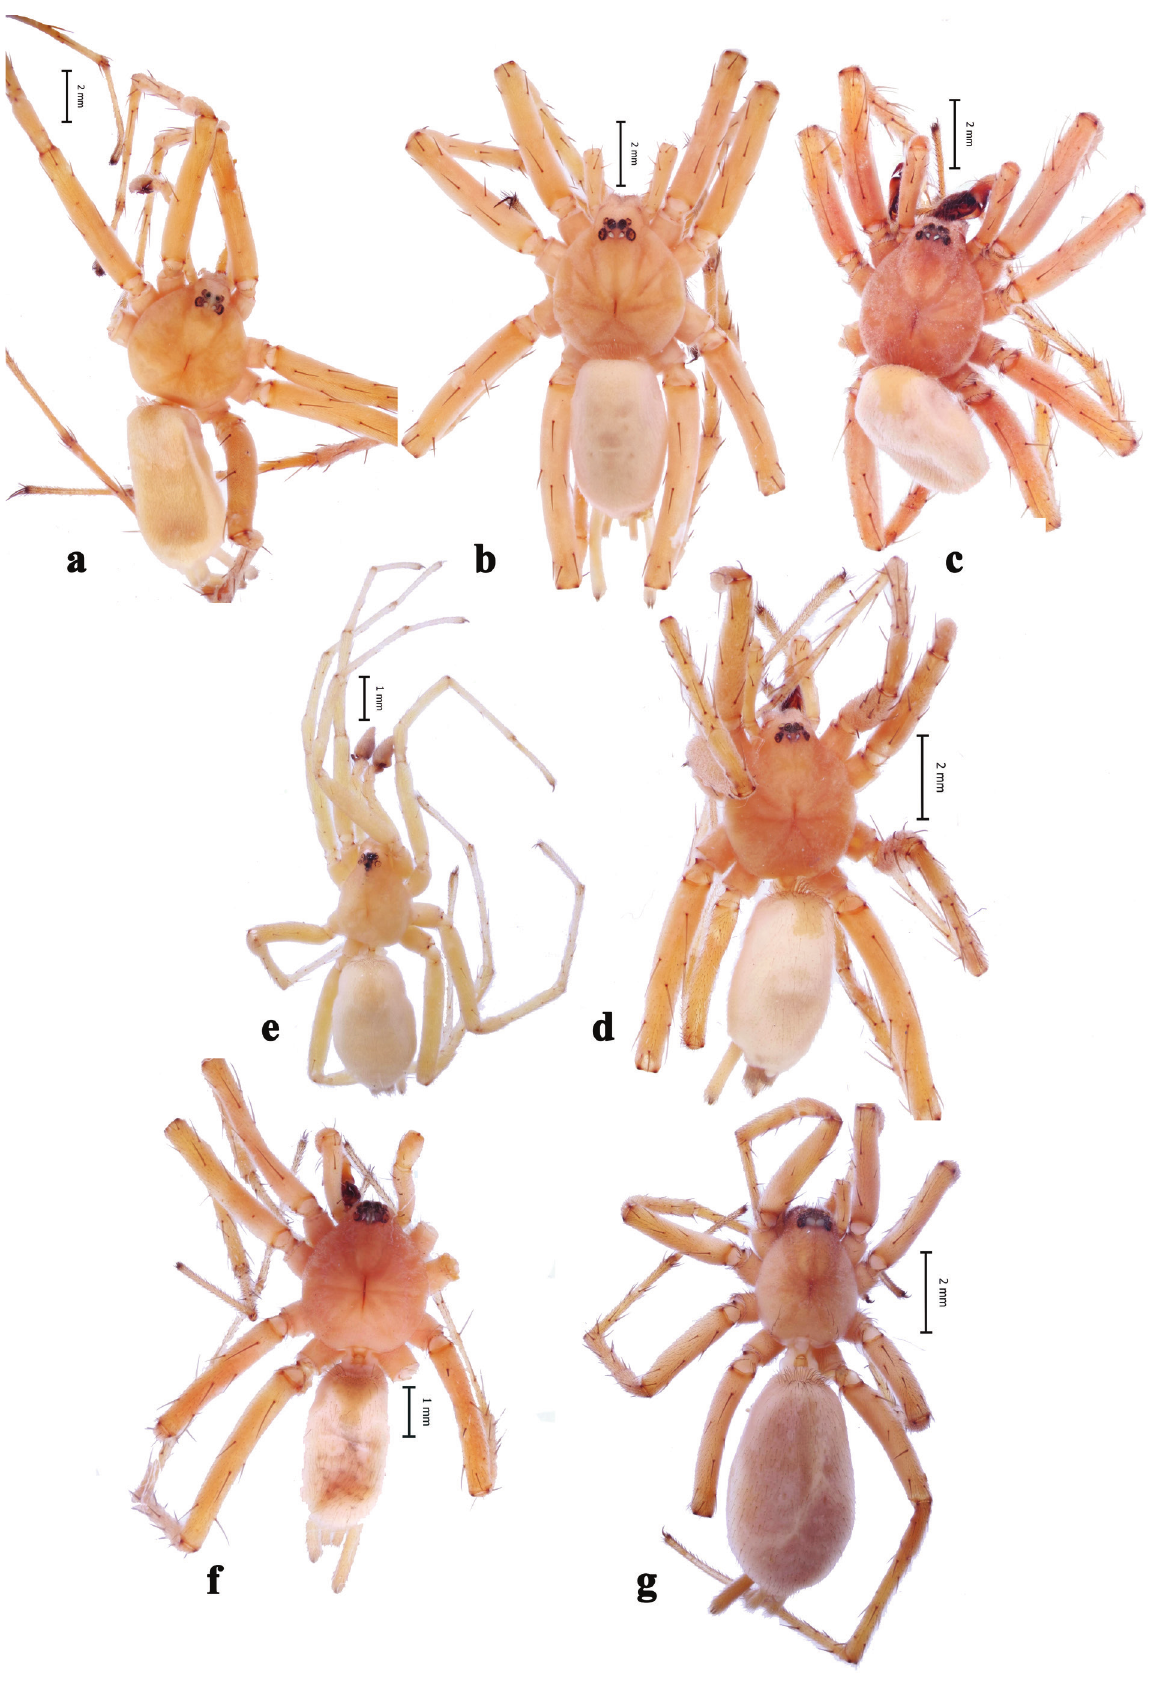
Figure 1. Dorsal habitus of Pterotricha spp.: a, b ) P. arabica sp. n., male and female; c ) P. esyunini sp. n., male; d ) P. nadolnyi sp. n., male; e ) P. stevensi sp. n., male; f, g ) P. dalmasi , male and